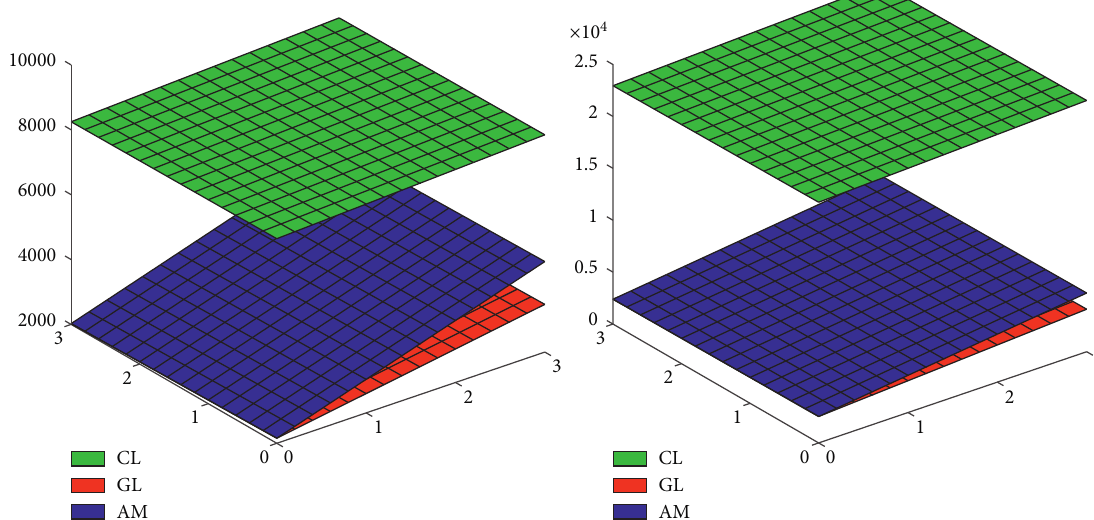
l l M and M . (a) 3D graphs of the first Zagreb index. (b) 3D graphs of the second m , GL m , and AM m using 1 2